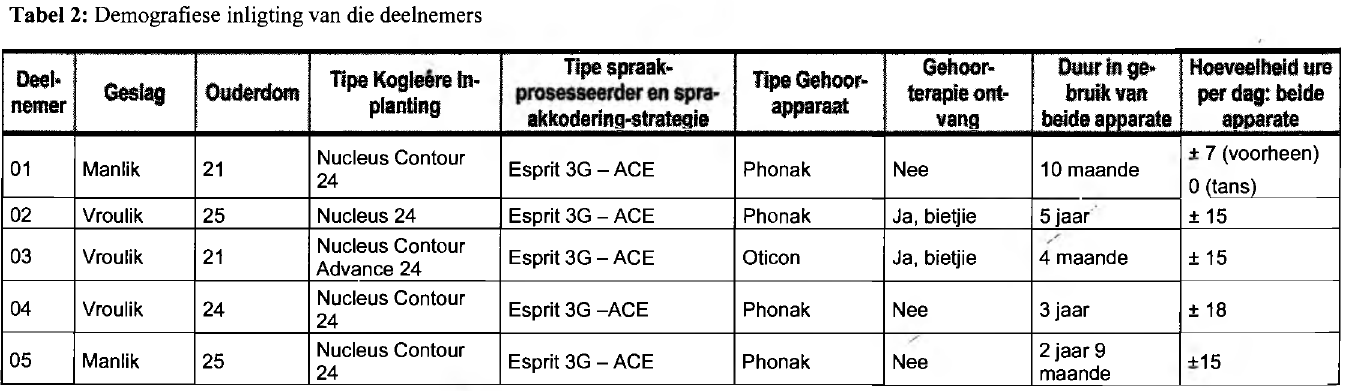
Tabel 2: Demografiese inligting van die